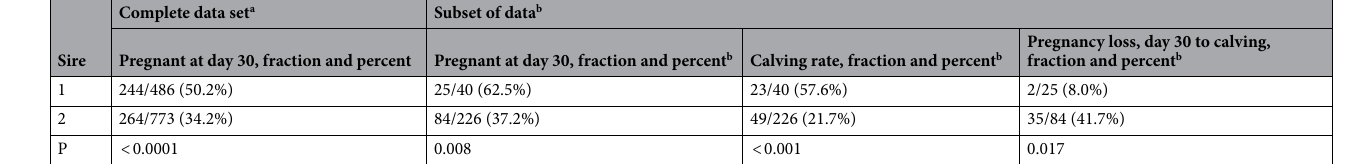
Table 3. Effect of sire used for in vitro fertilization on pregnancy outcome at day 30 of gestation, calving rate and pregnancy loss. a Data from 5 farms in which embryos produced from both sires were used. b Data from 1 farm in which calving information was